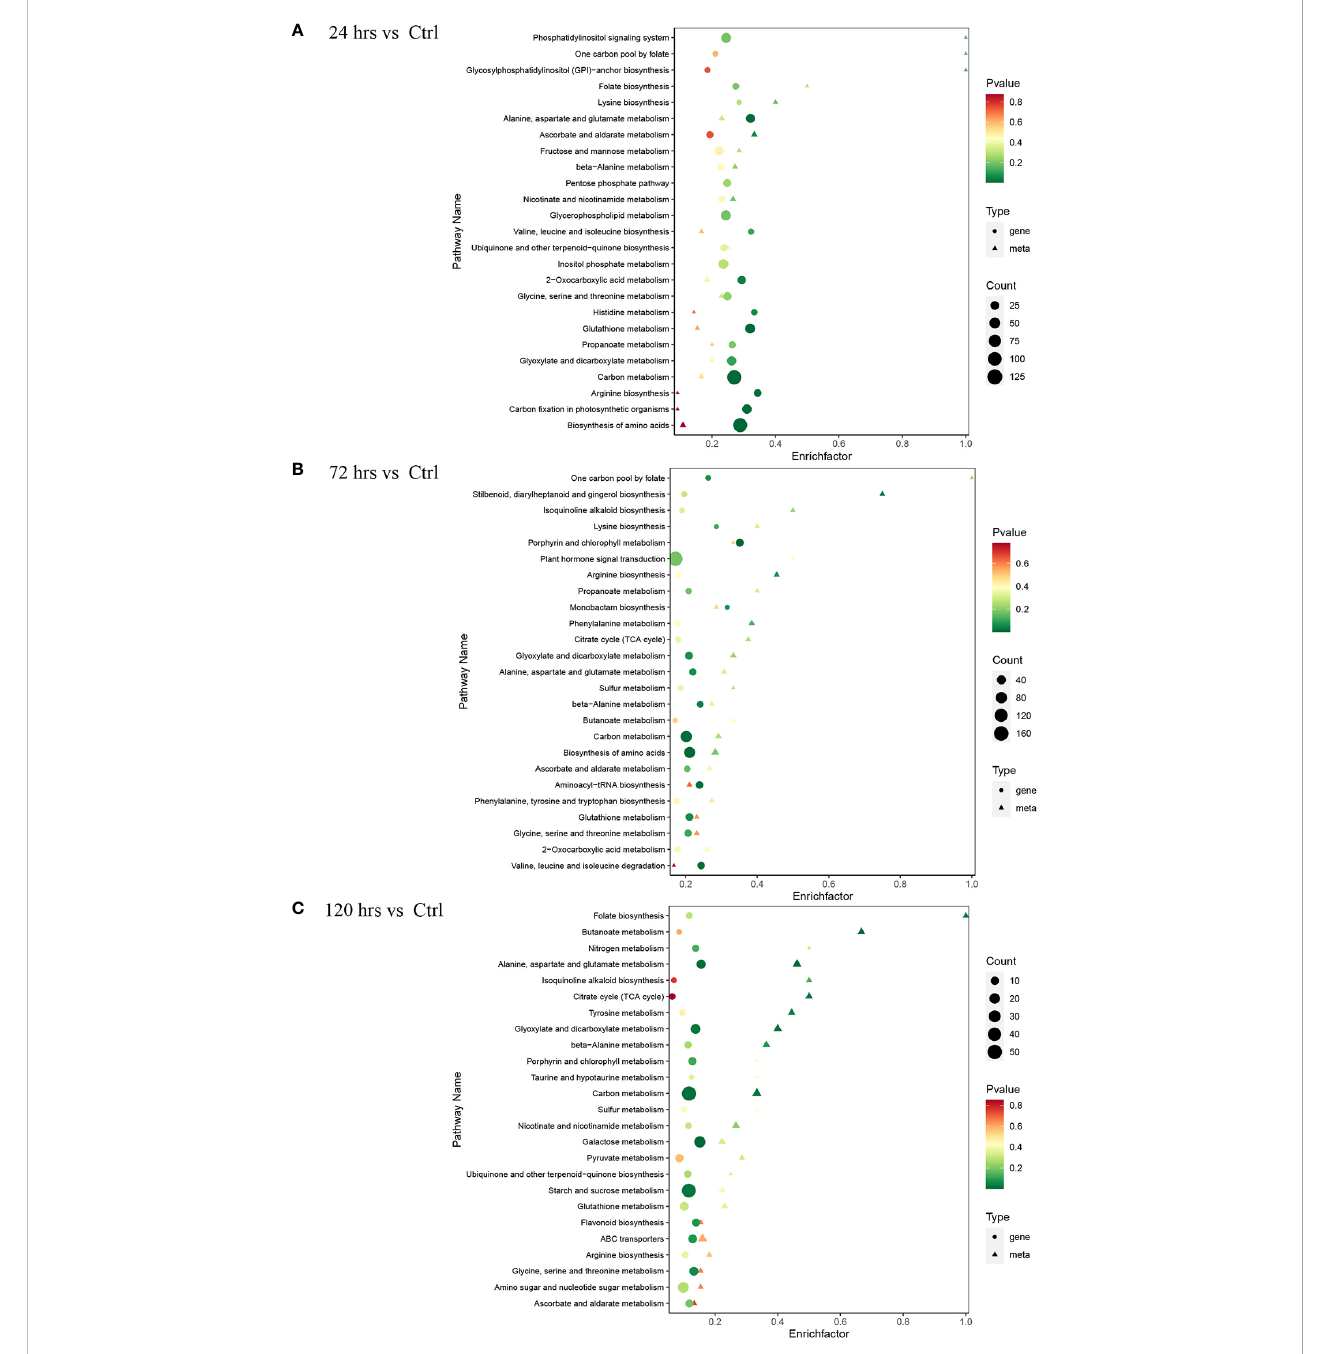
FIGURE 3 KEGG pathway enrichment analysis of differentially expressed genes and metabolites in the pumpkin at different time-points (only the top 25 signi fi cantly enriched pathways were displayed). (A) 24 hrs. (B) 72 hrs. (C) 120 hrs. The advanced bubble chart shows the enrichment of differentially expressed genes in various pathways. The y-axis represents pathways, and x-axis represents the enrich factors (enrich factor refers to the ratio of the number of regulated genes enriched in the pathway and the total amount of genes in the background in the same pathway). The greater rich factor indicates a higher enrichment. The size and colours (green, yellow, and red) of the bubble separately represent the amount of differentially expressed genes enriched in the pathway and its enrichment signi fi cance. The bigger bubble represents more associated genes regulated and enriched in the corresponding pathway. The smaller p-value represents better